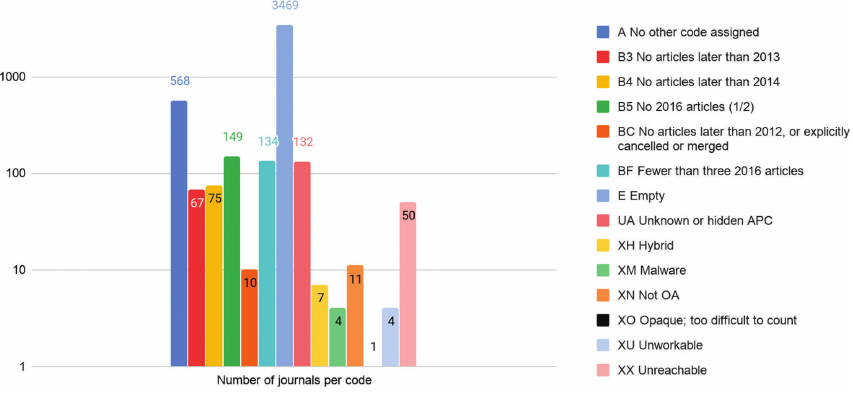
Fig. 1: The distribution of journals that we observed included in Cabell’s blacklist as per Crawford’s